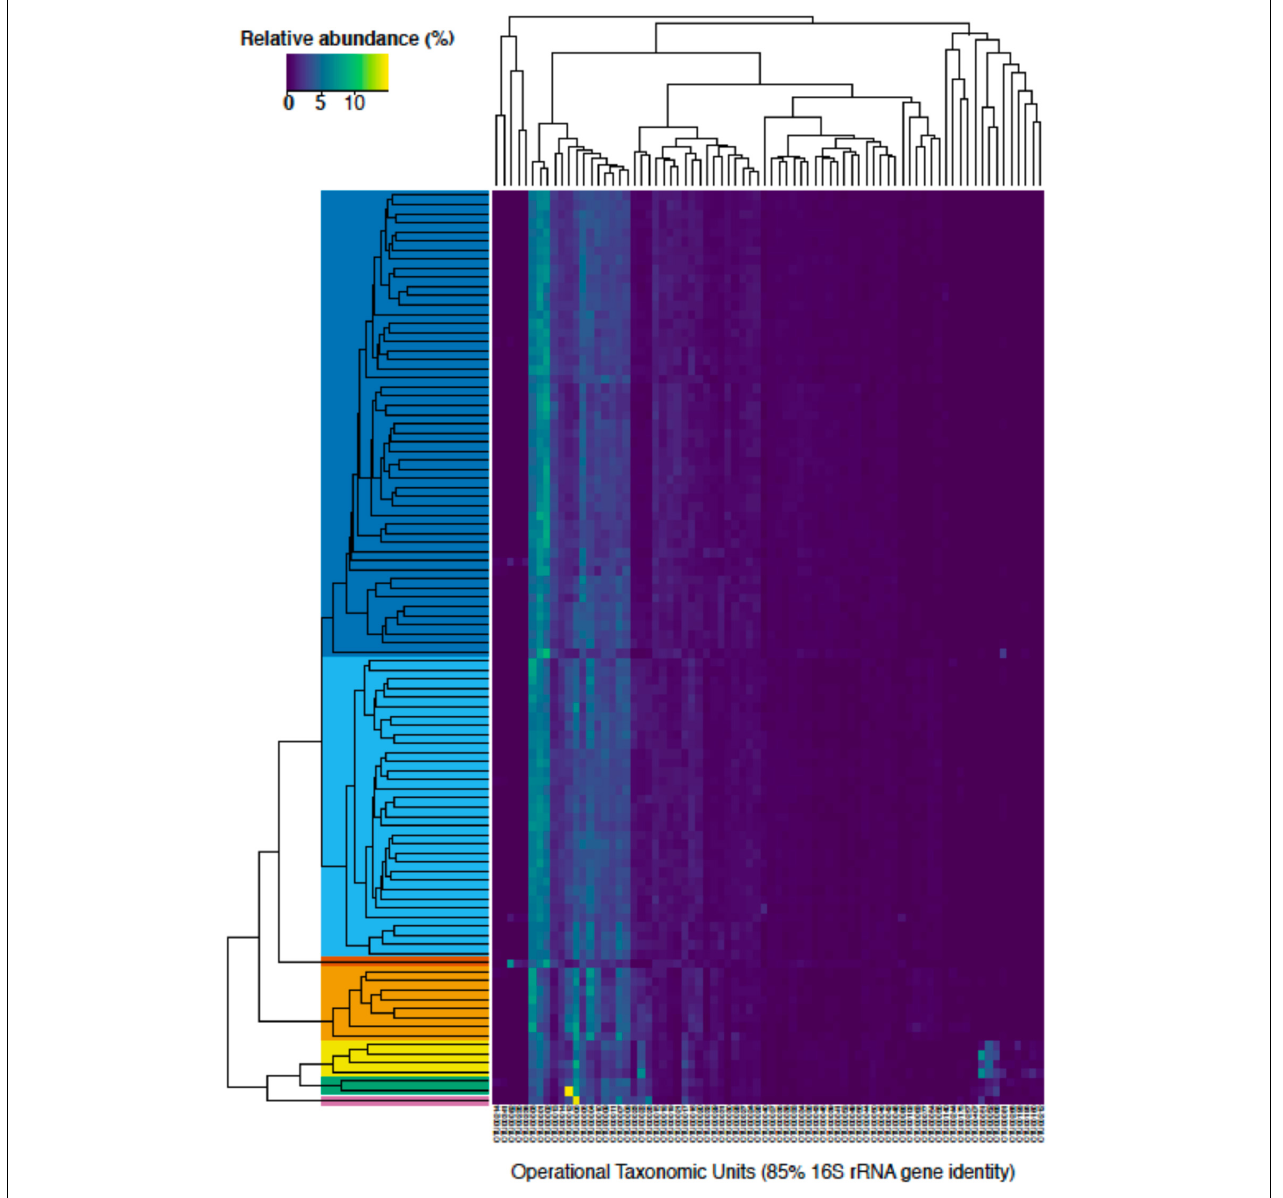
FIGURE 5 | A heatmap of the relative abundance of bacterial and archaeal taxonomic units (OTUs) clustered at 85% identity that were at least 0.5% relative abundance in one sample ( n = 76 OTUs). The different samples were clustered using average linkage hierarchical clustering of the Bray-Curtis dissimilarity as implemented in the R package vegan (Oksanen et al., 2019). Solid colors depict the different ecostates that were selected from the clustering analysis (see legend in Figure 6 ). OTU identifiers can be referenced with specific taxonomic groups in Supplementary Table 1 .